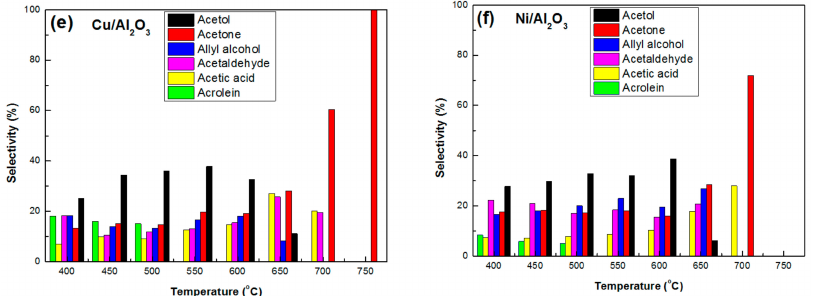
Figure 12. Comparative results obtained over the Ni/Ce-Sm-10Cu catalyst, the stand alone Ce-Sm-10Cu support and representative monometallic catalysts (Ni/Al 2 O 3 and Cu/Al 2 O 3 ): ( a ) Conversion to gaseous products; ( b ) H 2 selectivity; ( c ) CO 2 selectivity; ( d ) CO selectivity; ( e ) Selectivity of liquid products over Cu/Al 2 O 3 ; and ( f ) Selectivity of liquid products over Ni/Al 2 O 3 [Results obtained for samples tested under experimental protocol #1].